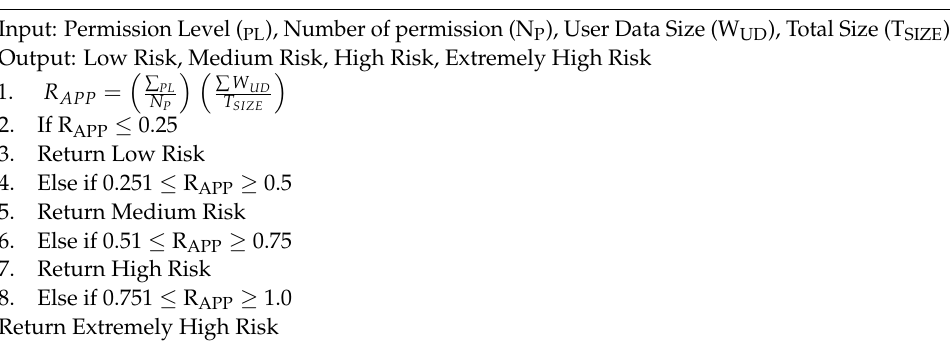
Algorithm 1: Calculate risk of each app (permission, number of permissions, user data